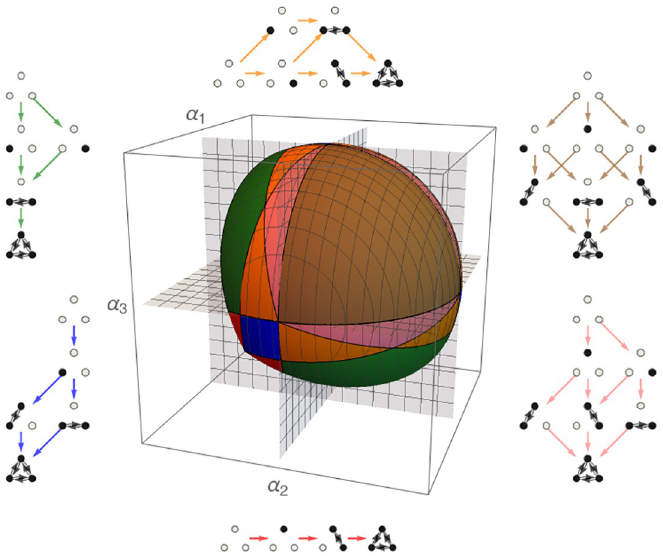
Fig 8. Cone of maximal biodiversity for a three-nodes LV cooperative system. Each color corresponds to a kind of information structure, also represented. The union of all regions produces the cone where structural stability is defined in the sense of [39]. Observe the rich presence of different attractors in the same cone, producing different dynamics with a same globally stable point. Each of these attractors is structurally stable under autonomous and nonautonomous perturbations [34], producing the structural stability of the whole cone. These coloured areas are the minimal structural stable zones, so defining with full precision the observed dynamics, in particular metastability effects, and predicting sudden bifurcation in